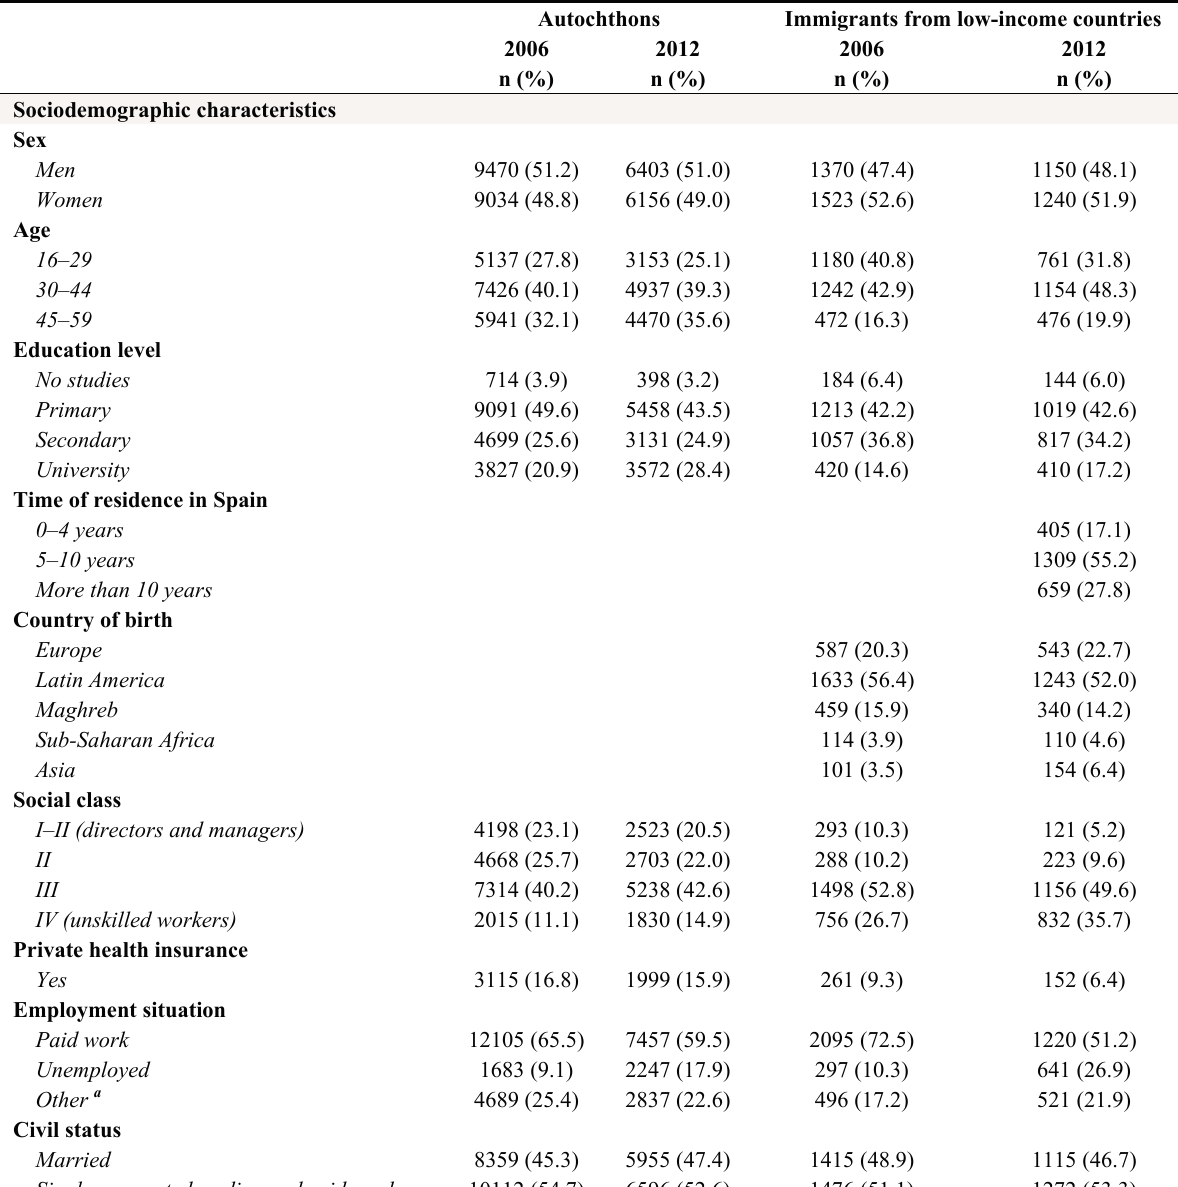
Table 1. Sociodemographic characteristics and health needs in autochthons and immigrants. SNHS 2006/07 and